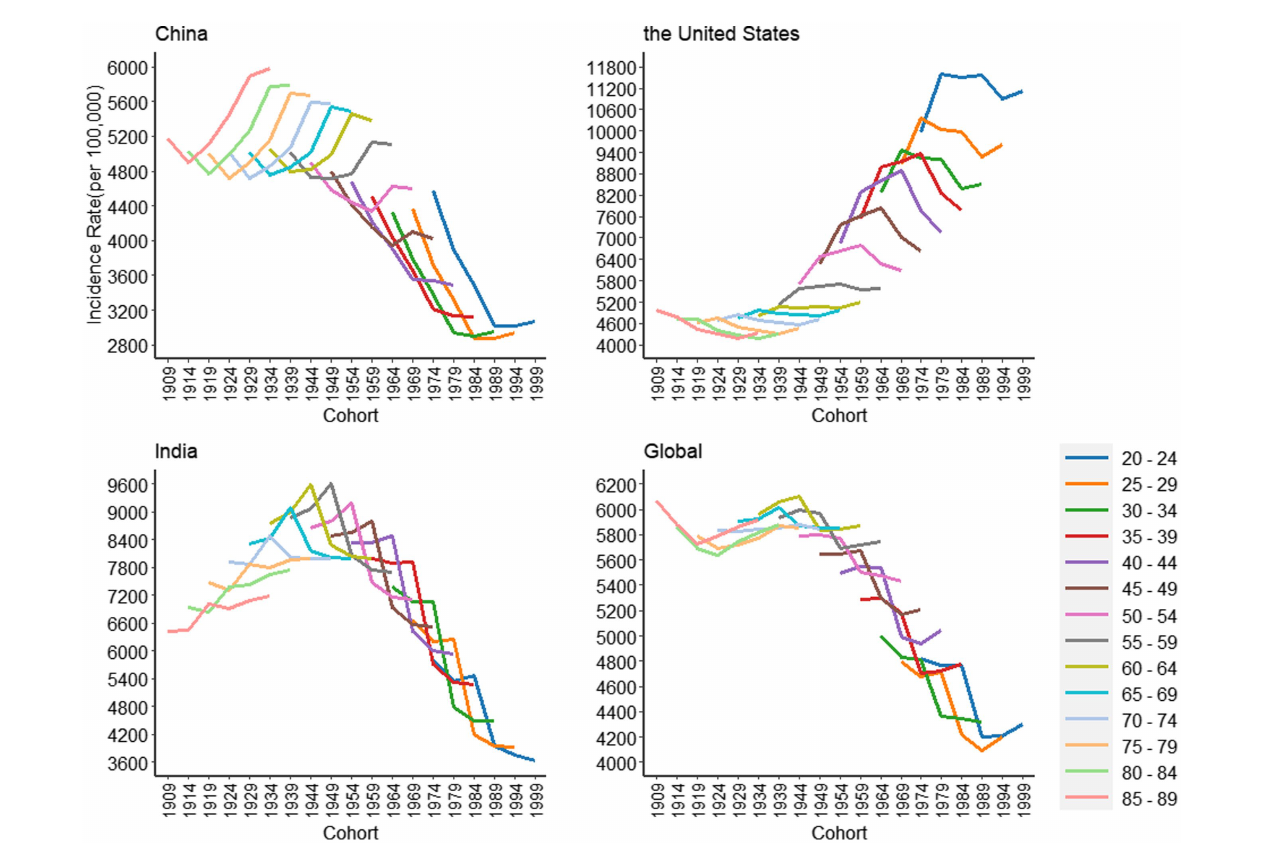
FIGURE 4 Cohort-based variation in age-standardized incidence rates for depressive disorders in China, the United States, India and the global, 1990 to